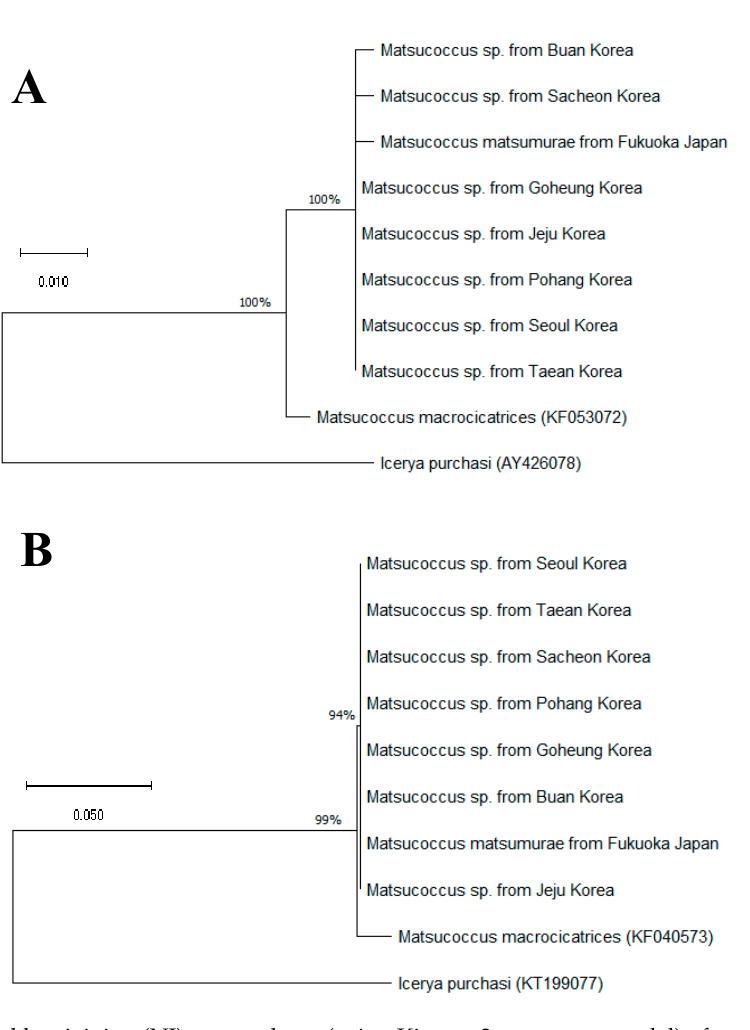
Figure 6. Morphological comparison of the adult males from Goheung (first) and Fukuoka (second).